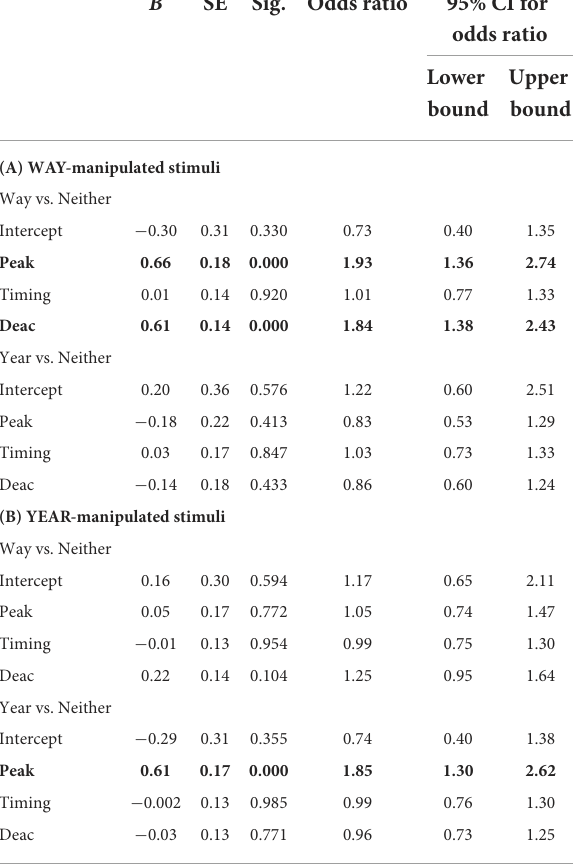
TABLE 4 Estimated coefficients, confidence intervals and t values for the mixed effect model fitted to the perceived prominence magnitude data (Test